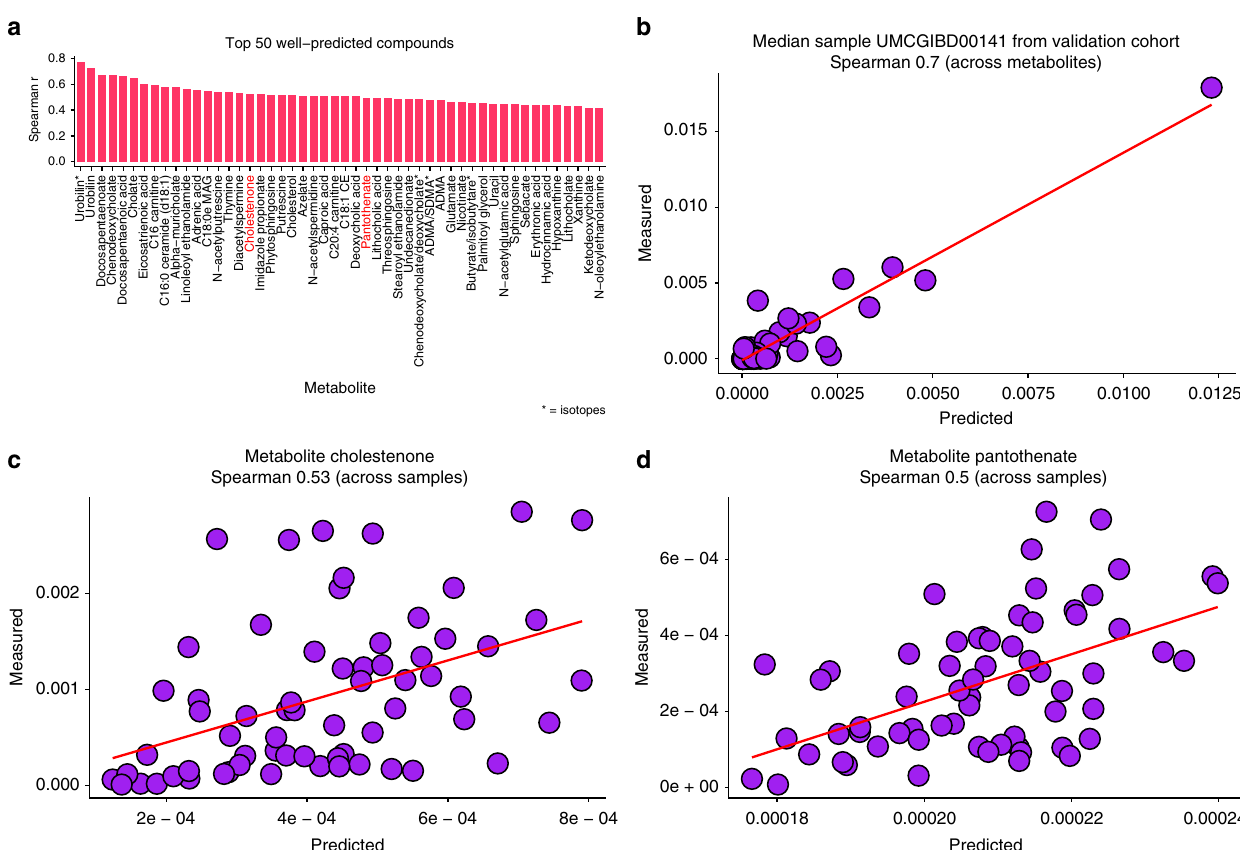
Fig. 2 MelonnPan accurately predicts metabolite features based on metagenomic sequence pro fi les. a From a panel of 466 metabolites whose identities were con fi rmed against laboratory standards, these 50 were the best predicted by MelonnPan with unique Human Metabolome Database (HMDB) identi fi ers (as measured by Spearman correlation ( r ) of predicted versus measured pro fi les in the Netherlands in fl ammatory bowel disease (NLIBD) independent validation cohort). All metabolites shown have r > 0.3 over a total n = 65 NLIBD samples. Two representative metabolites are shown in red. b Measured and predicted metabolite pro fi les across a single representative sample were strongly and signi fi cantly associated across 107 labelled metabolites (including both unique and non-unique compounds that were well predicted by MelonnPan). c Representative signi fi cant prediction for cholestenone in the test set. d Representative statistically signi fi cant prediction for pantothenate in the NLIBD validation data (values are relative abundances). See Supplementary Figs. 1 – 2 and Supplementary Data 1 – 6 for full results. For each scatter plot, the best fi tting regression line is also